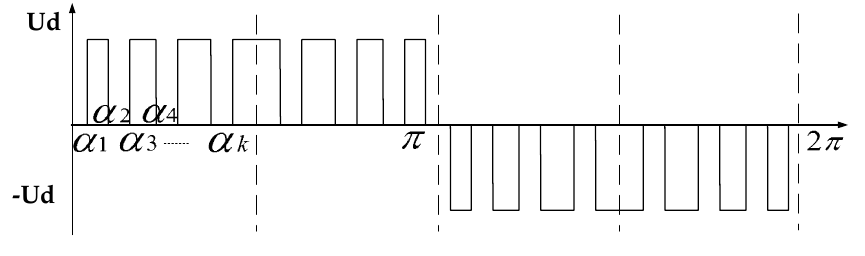
Figure 9. Three-level pulse waveform.